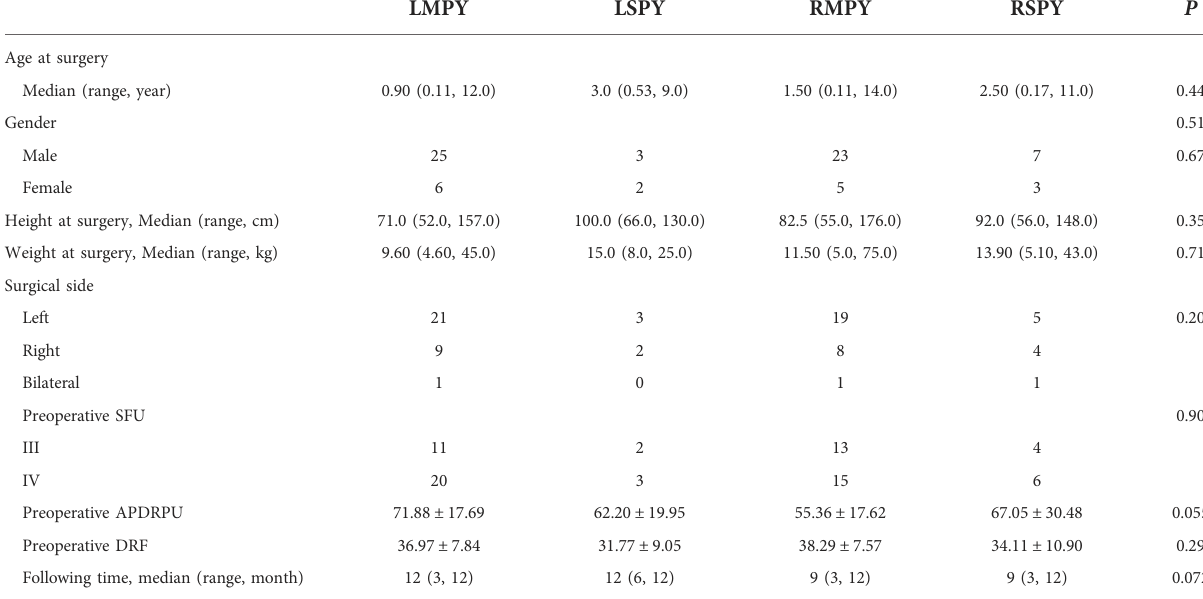
TABLE 1 Patients ’ characteristics and preoperative data of